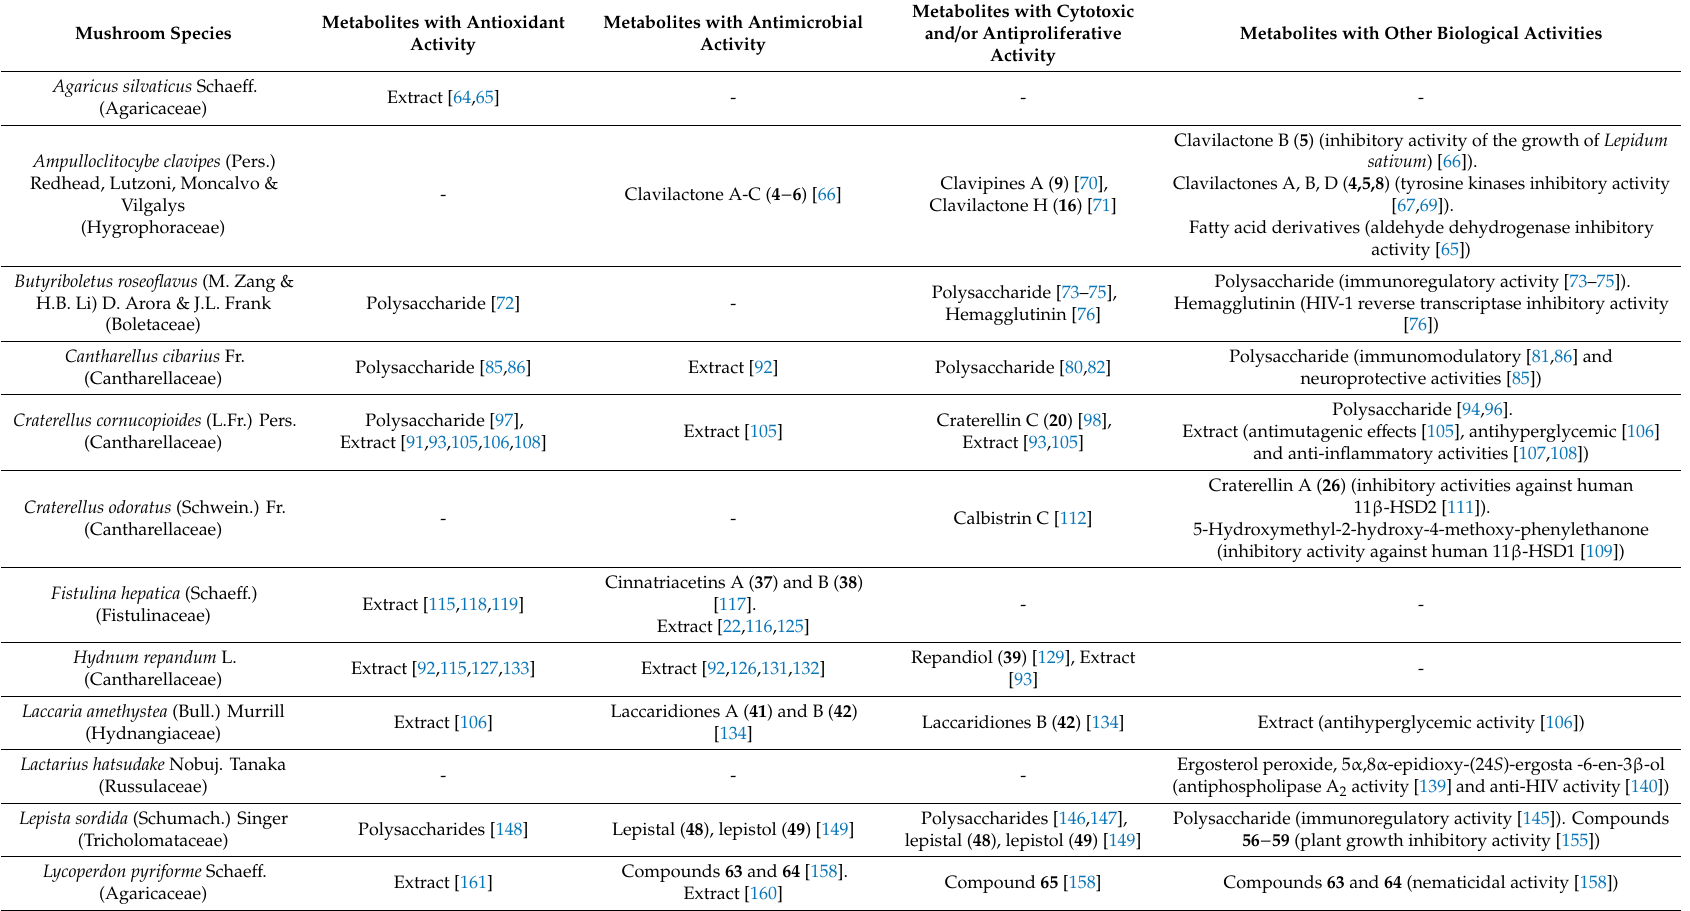
Table 1. Biological / pharmacological activities of extracts / compounds isolated from selected wild edible mushrooms growing in Southeast Asia